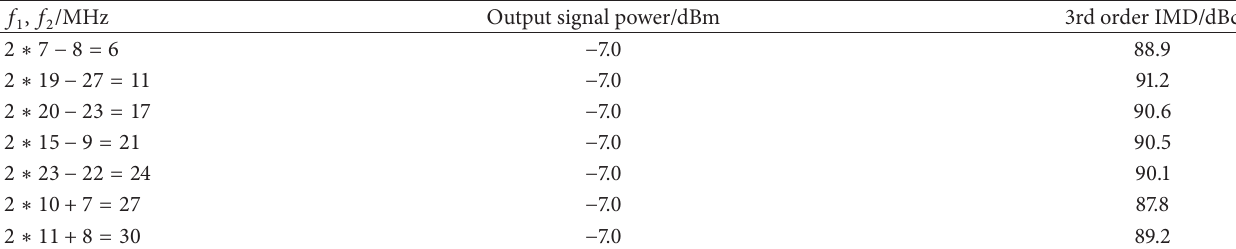
Table 2: Third order IMD